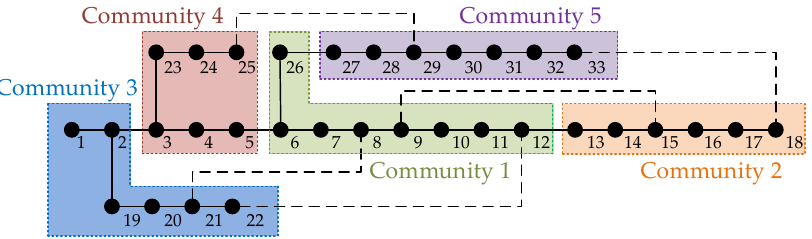
Figure 1. Community structure of the IEEE 33-node test feeder.